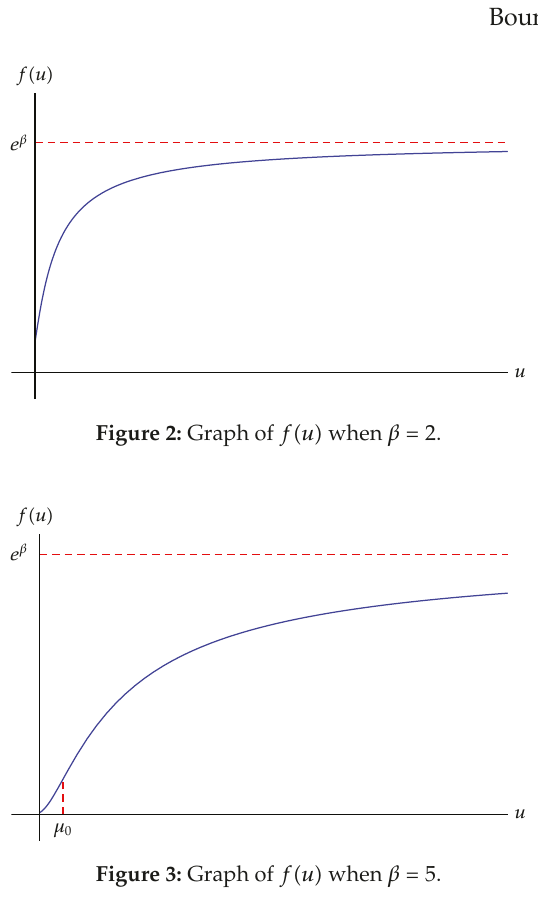
Figure 3: Graph of f (cid:4) u (cid:5) when β (cid:3)